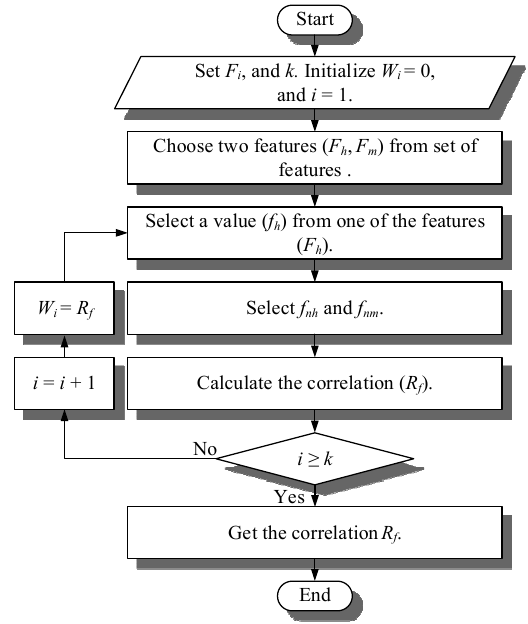
Figure 7. Flowchart of the Relief.